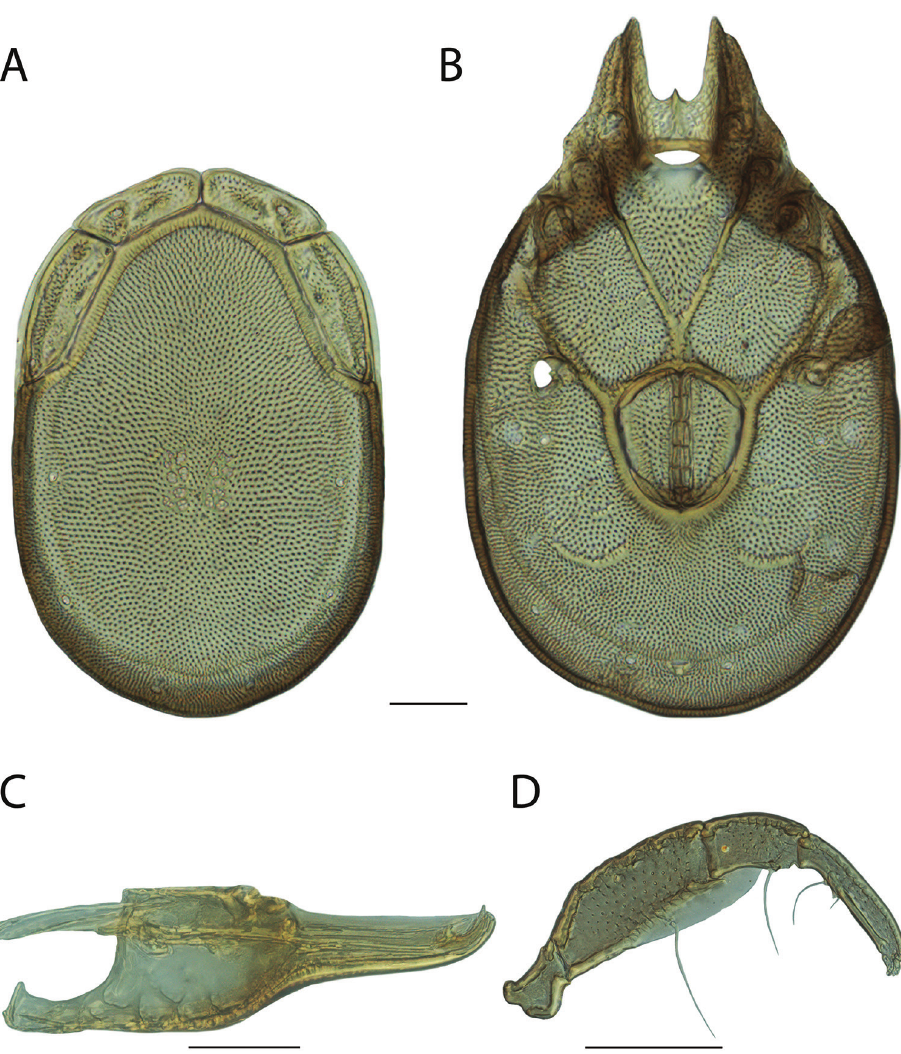
Figure 124. Torrenticola lamellipalpis female: A dorsal plates B venter (legs removed) C subcapitulum D pedipalp (setae not accurately depicted). Scale = 100